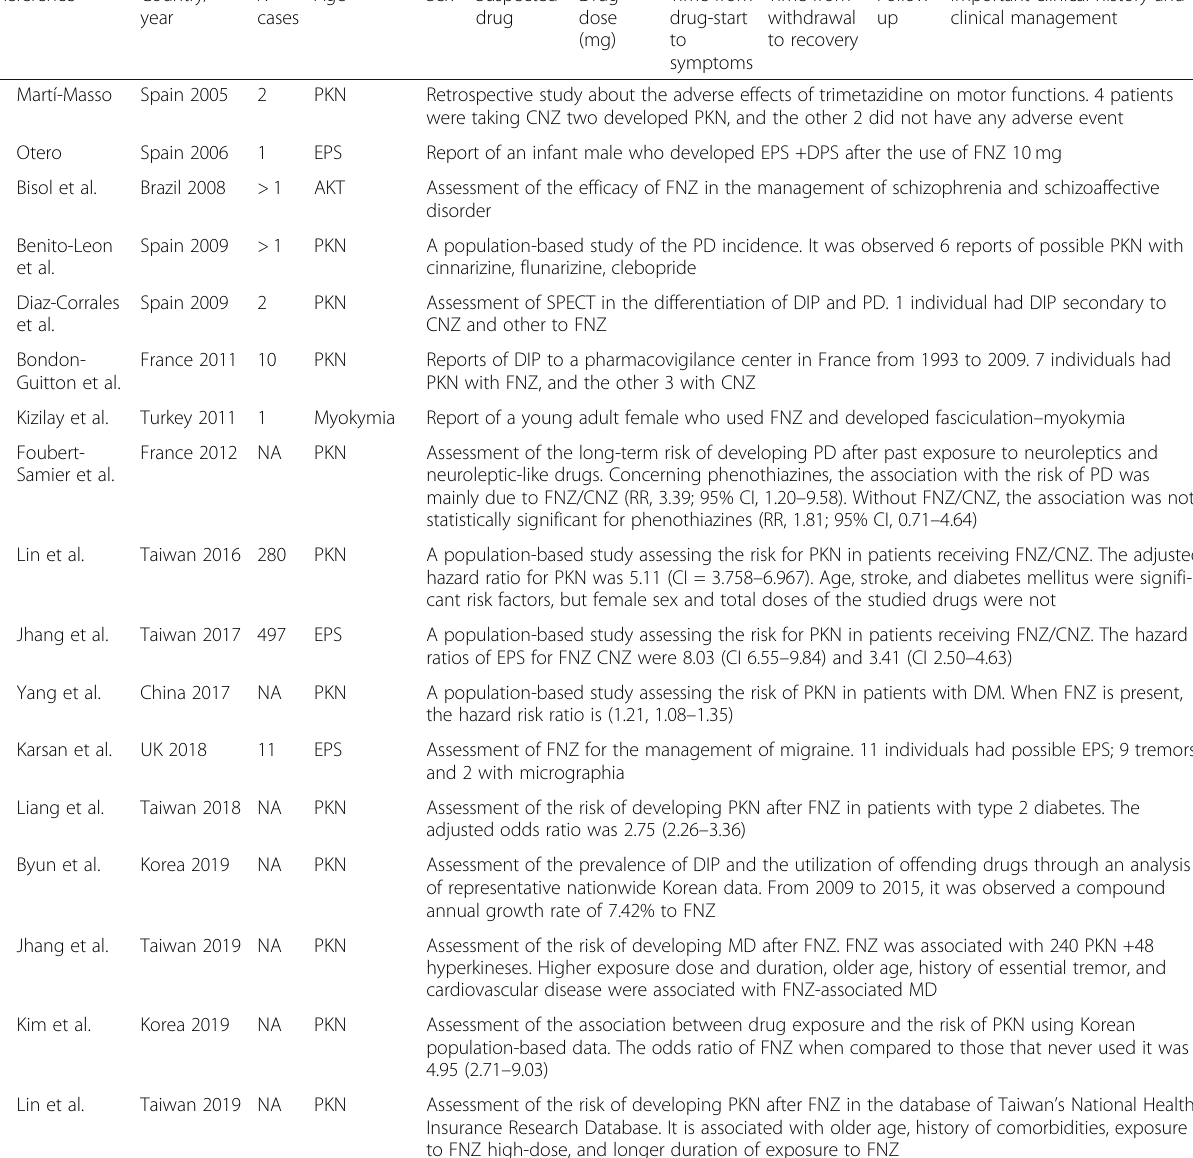
Abbreviations : AKT akathisia, BD bipolar disorder, CH clinical history, CM clinical management, CNZ cinnarizine, CR complete recovery, DIP drug-induced parkinsonism, DKN dyskinesia, DPS depression, DTN dystonia, EPI epilepsy, EPS extrapyramidal symptoms, F female, FNZ flunarizine, M male, MCL myoclonus, MD movement disorder, NA not applicable/not available, NR not reported, PKN parkinsonism, PD Parkinson ’ s disease, FNZ/CNZ flunarizine or cinnarizine, FNZ+CNZ flunarizine combined with